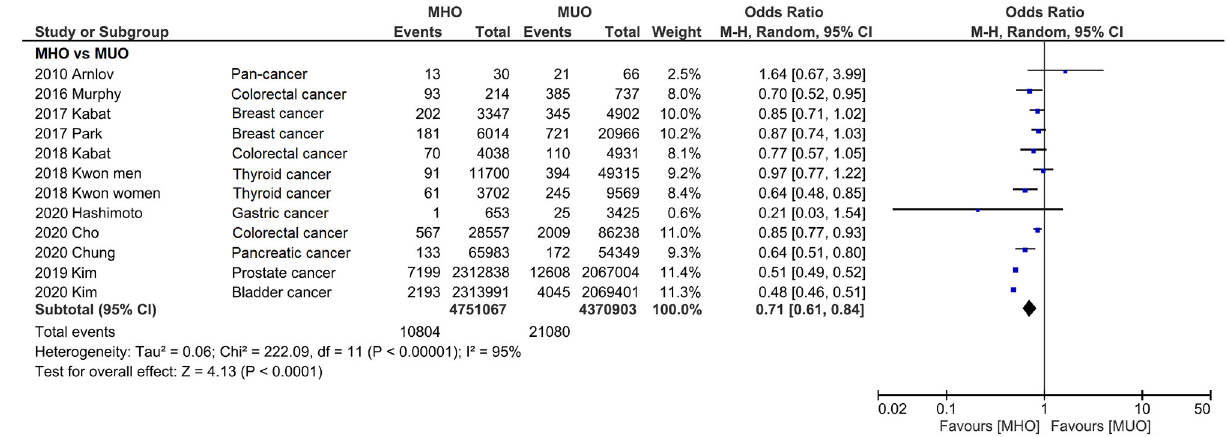
reported the data of men and women (34), those data were also separately presented in the present